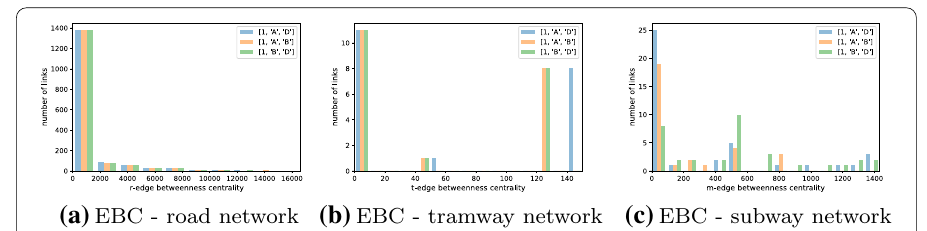
Fig. 13 Evolution per transport mode of DAEBC in the “Festival of Lights”